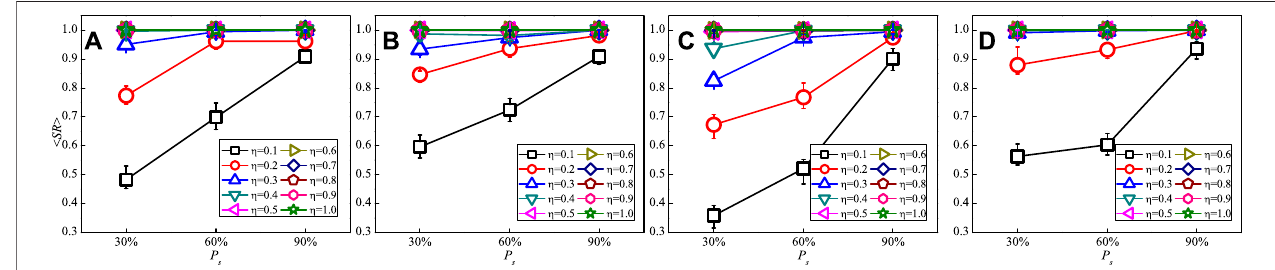
FIGURE 3 | (Color Online) The mean success rates of existent links 〈 SR 〉 of reconstructing four types of networks: (A) small-world network with 120 nodes, (B) randomnetworkwith120nodes, (C) regularnetworkwith120nodes, (D) Apolloniannetworkwith124nodes,hostingaPDGdynamicalprocess.Thelineswithdifferent symbols are the mean success rates of existent links 〈 SR 〉 obtained by EEM when the index of information suf fi ciency rate η catches different values. The mean reconstruction accuracy indices are achieved by averaging over 50 independent experimental results. For each experiment, measurements are randomly picked from a time series of temporary evolution. The priori information of the structure, measured by a probability P s , indicates the amount of available priori information of the structure used in the reconstruction. The payoff parameter for the PDG is b (cid:1) 1.2.